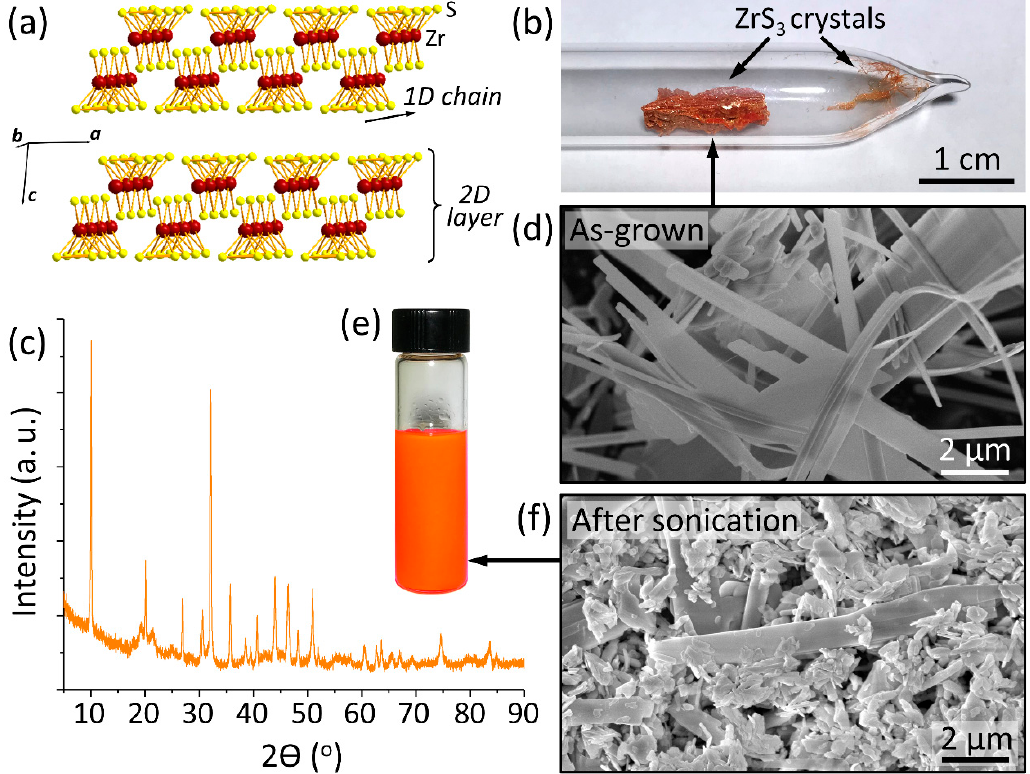
Figure 1. ( a ) Crystal structure of ZrS 3 ( P 2 1 / m space group); ( b ) optical photograph of an evacuated quartz ampule with orange ZrS 3 crystals indicated by the arrows; ( c ) XRD spectrum of ZrS 3 crystals; ( d ) SEM image of the as-grown ZrS 3 crystals shown by the arrow in panel b; ( e ) optical photograph of a vial with 1 g / L suspension of exfoliated ZrS 3 crystals, which were dispersed in PS solution by sonication; ( f ) SEM image of ZrS 3 particles after sonication in PS solution.